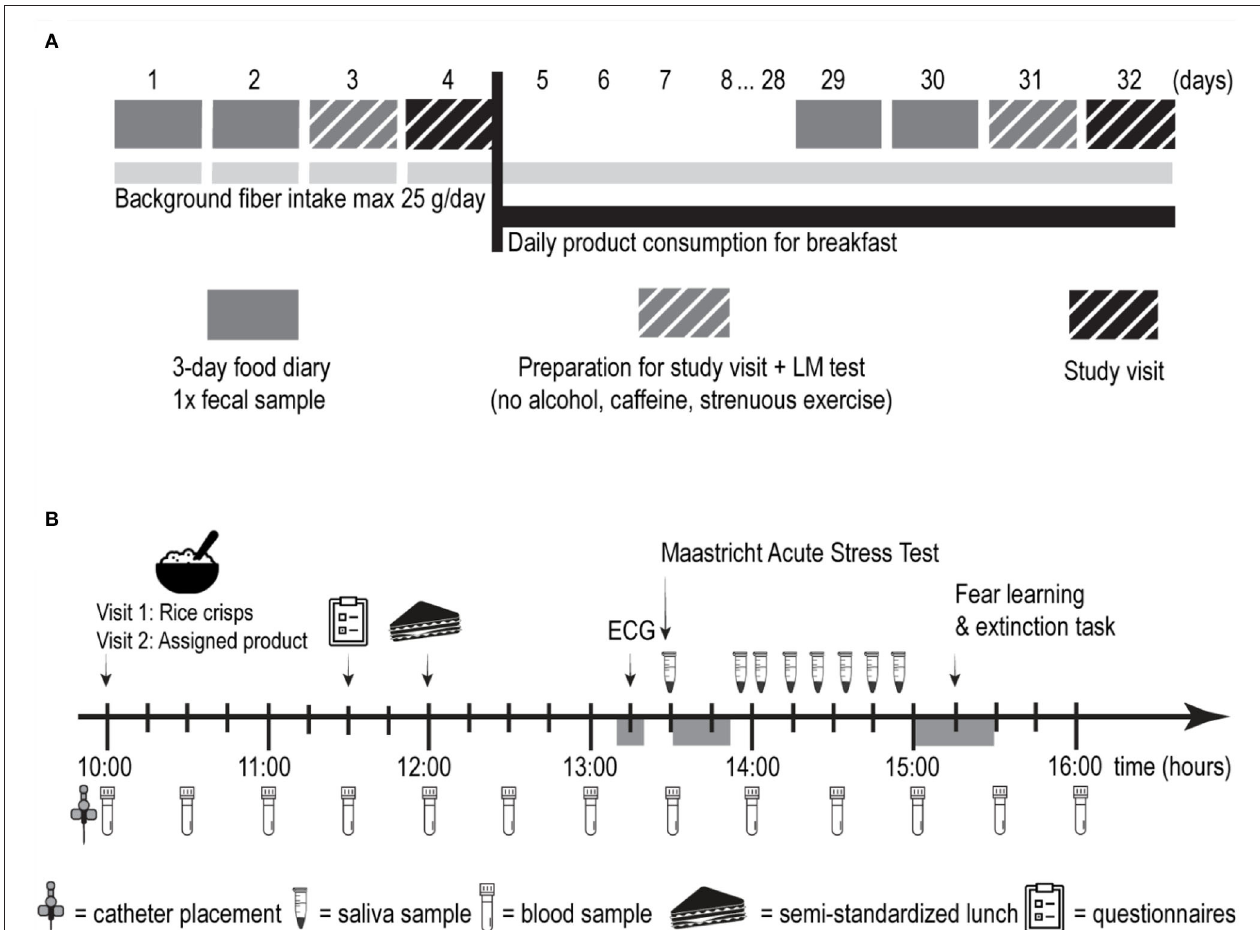
FIGURE 1 | Overview of the experimental protocol. (A) Overview of the study design. (B) Schematic overview of one study visit. LM, lactulose/mannitol; ECG, electrocardiography.